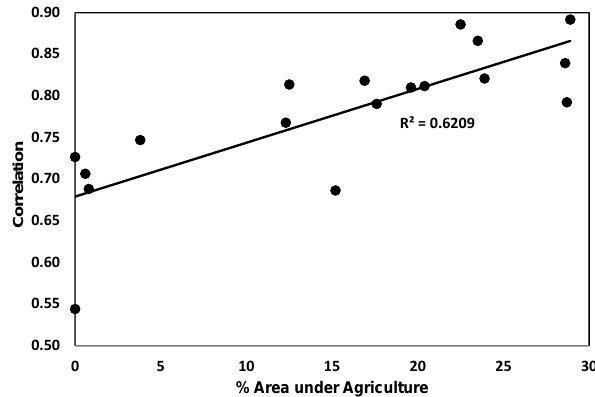
Figure 10. Role of the type of land use and percentage area under Figure 10: Role of the type of land use, percentage area under agriculture, in influencing the 761 agriculture in influencing the forecast skill, which is expressed as forecast skill which is expressed as the correlation coefficient between the observed TN loadings 762 the correlation coefficient between the observed TN loadings and the forecasted TN loadings for the 18 selected and the forecasted TN loadings for the 18 selected watersheds. 763